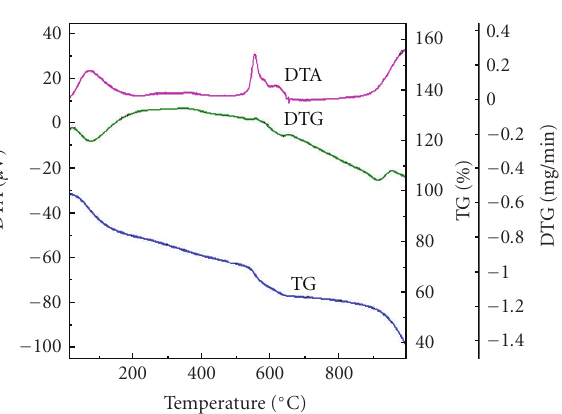
Figure 4: Simultaneous TGA-DTA curves of poly-o-anisidine Sn(IV) arsernophosphate composite cation exchanger.